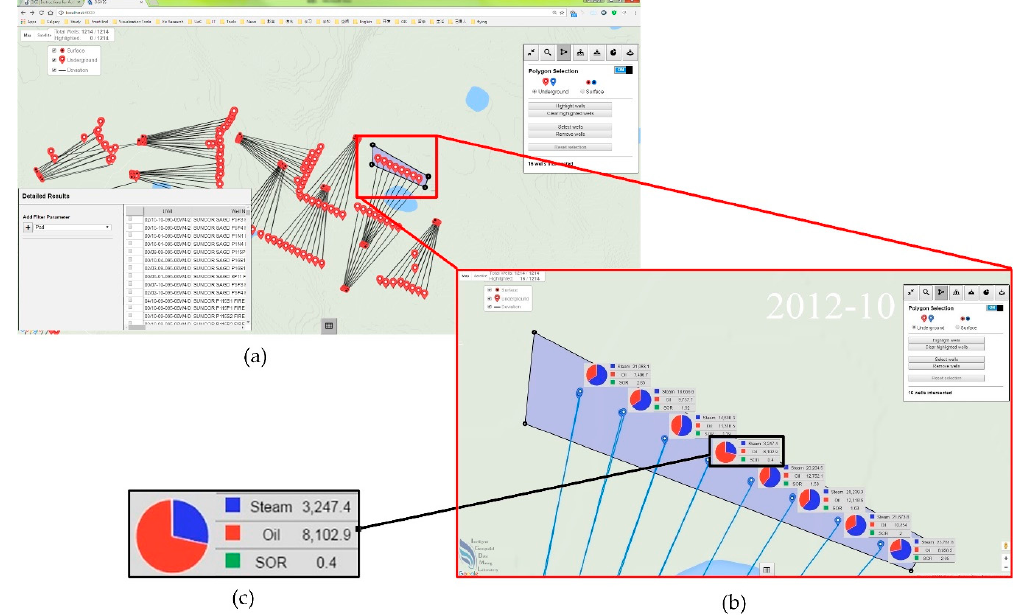
Figure 8. Overview of Project Cenovus Christina Lake with a bubble map: ( a ) overview of wells’ spatial distribution; ( b ) overview of multiple variables of Pad B-03 ; ( c ) enlarged individual bubble pie charts presenting production-related values.